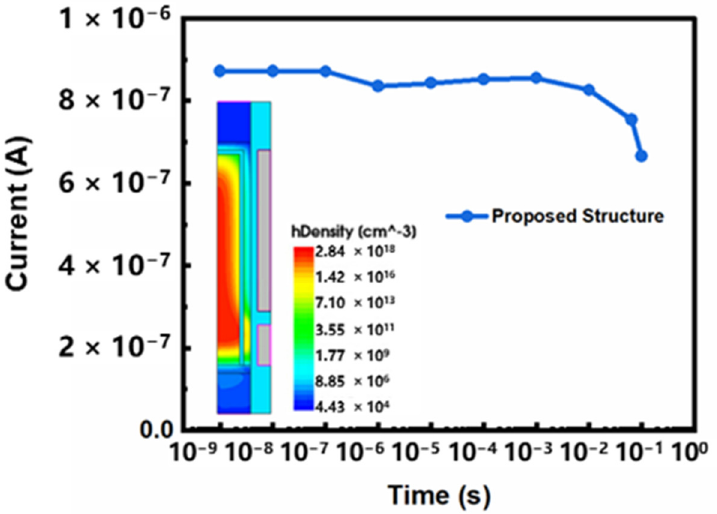
Figure 6. The reading current of the proposed structure after holding “1” state for different times at 85 °C.